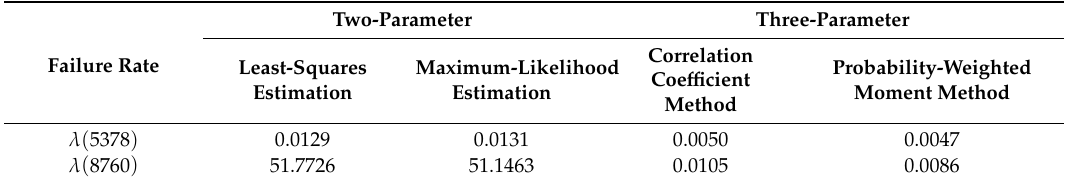
Table 3. Short period prediction on failure rates.